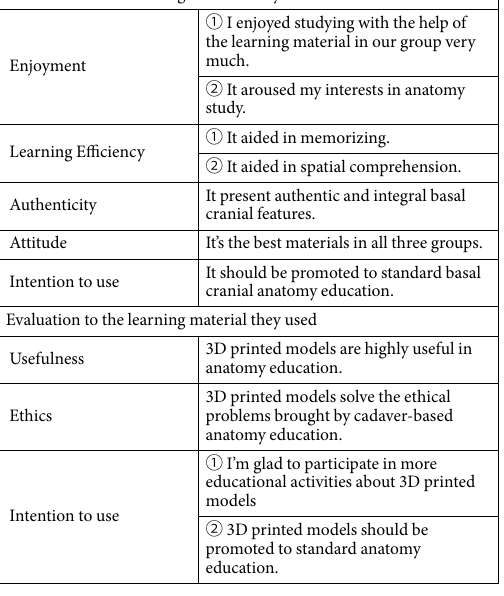
Table 1. Subjective evaluation questionnaire (1-strongly disagree, 5-strongly